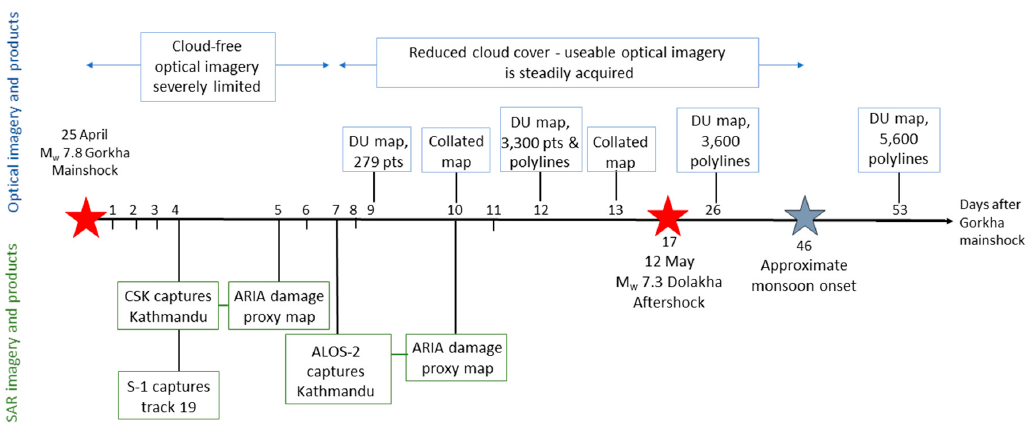
Figure 2. Timeline showing satellite image acquisition and product release following the 2015 Gorkha earthquake for optical satellite imagery and for SAR. Modified from [9]. Timeline of NASA Advanced Rapid Imaging and Analysis (ARIA) products is taken from [21]. Optical imagery and products are in blue with maps produced by Durham University (DU) and collated maps coordinated with international partners (International Centre for Integrated Mountain Development (ICIMOD), MacDonald, Dettwiler and Associates Ltd, (MDA) and the National Geospatial-intelligence Agency (NGA)) by the British Geological Survey. SAR imagery and products are in green and include the Sentinel-1 (S-1) imagery used in this study and the COSMO SkyMed (CSK) and ALOS-2 imagery of Kathmandu used by the ARIA project.